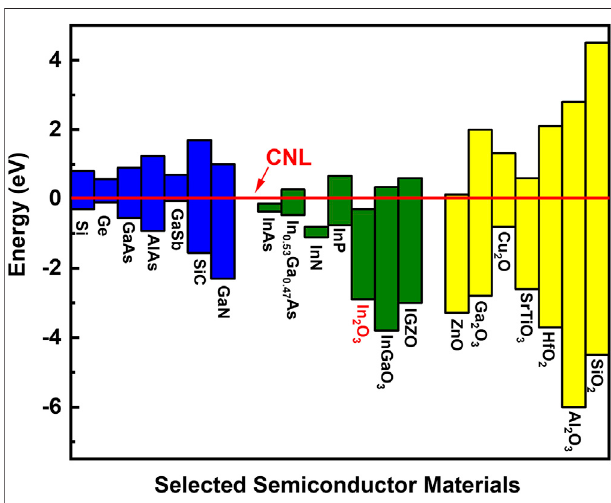
FIGURE 4 | CNL alignments of the selected semiconductor materials including conventional semiconductors and oxide